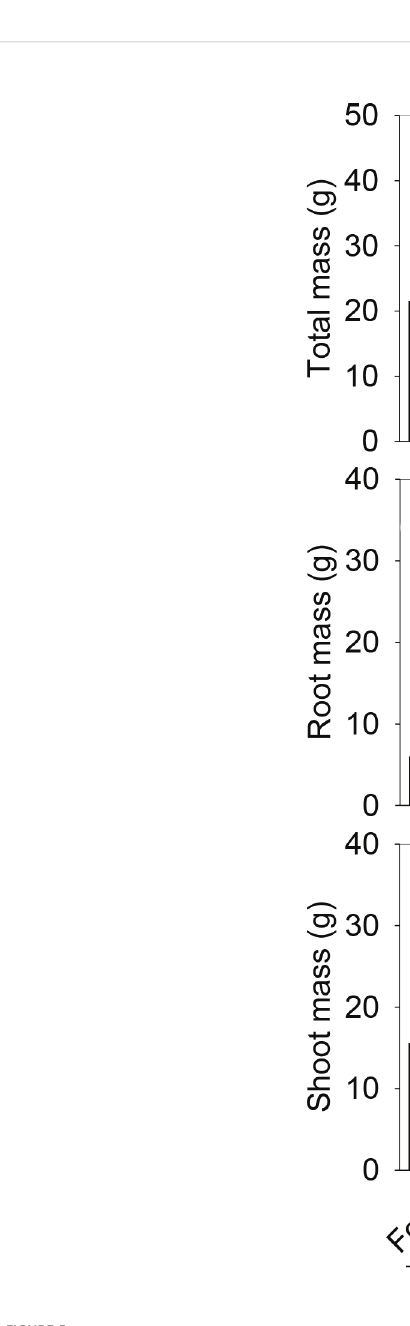
FIGURE 5 (A) Total, (B) root and (C) shoot biomass of the plant communities in the (imagined) high- and low-quality patches in the homogeneous and the heterogeneous treatment for each of the thee microplastic shapes. Bars and vertical lines are mean and SE. Symbols (*** P < 0.001 and * P < 0.05) indicate signi fi cant differences between the high-and low-quality